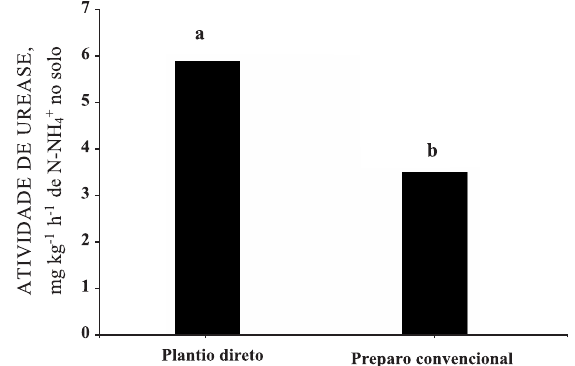
Figura 2. Atividade de urease na camada de 0–10 cm de solo no estádio de floração da cultivar de feijoeiro BRS Valente em função do sistema de preparo do solo. Médias seguidas por